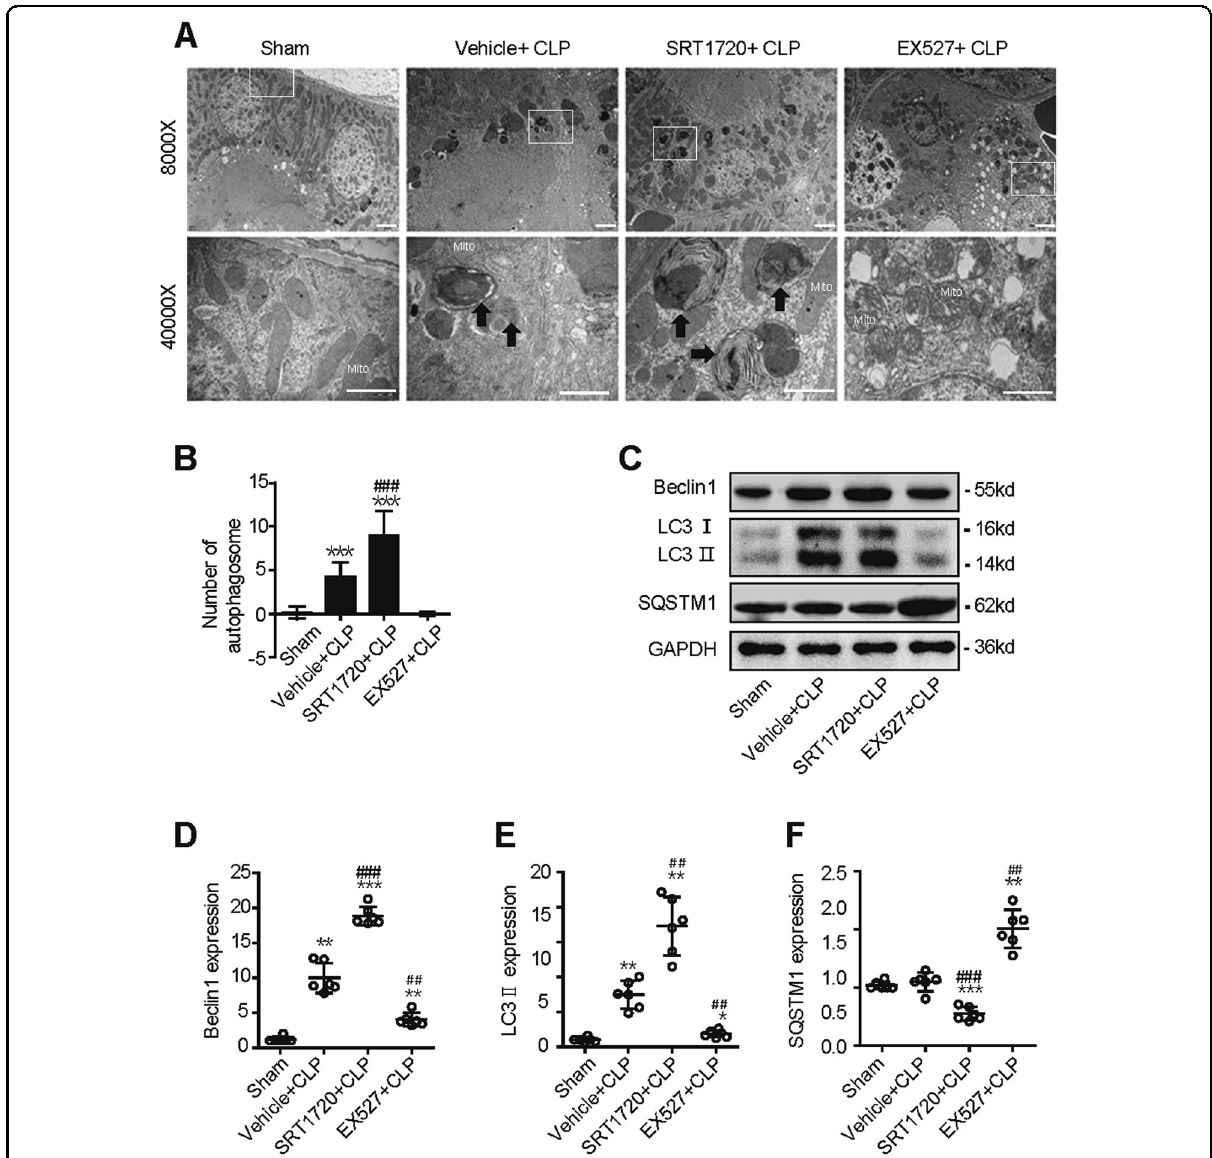
Fig. 3 SIRT1 attenuates SAKI by promoting autophagy. Mice was pretreated with SRT1720 or Ex527 for 2h before CLP surgery to activate or inhibit SIRT1, respectively. Kidney tissue samples were collected 12h after CLP surgery. A , B The kidney cortex was observed and the number of autophagosomes was calculated in 20 randomly selected fi elds using a transmission electron microscope (black arrow: autophagosomes; Mito: mitochondrion; upper panel: magni fi ed ×8000 and scale bar = 2 μ m; lower panel: magni fi ed ×40000 and scale bar = 1 μ m, n = 20). C – F Representative western blot and densitometric analysis of Beclin1, LC3 II and SQSTM1 protein expression ( n = 6). The data are presented as the mean ± SD. * p <0.05, ** p <0.01 and *** p < 0.001 vs the sham group; ## p <0.01, ### p <0.001 vs the vehicle + CLP group. SAKI sepsis-induced acute kidney injury, CLP caecal ligation and